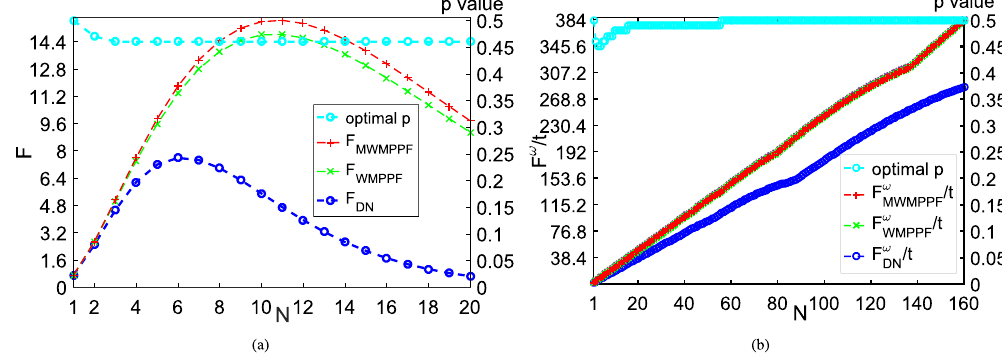
Figure 7. ( a ) Average QFI of phase φ vs. N and optimal p of F MWMPPF vs. N with N = 1 to 20 while r = 0.3, θ = π /2. (1) F DN (blue dashed line) for DN case; (2) F WMPPF (green dashed line), provided that p is fixed with 0.5; (3) F WMWPPF (red dashed line) is the maximum of F WMPPF by choosing the optimal p value when r = 0.3; (4) the optimal p value for average QFI (celeste dashed line) according to N can be drawn at the same parameters with the coordinate scale on the right edge of the figure, which is the p of F MWMPPF . ( b ) Average QFI of frequency ω divided by t (or average QFI of phase multiplying t ) vs. N and optimal p of ω F t / vs. N with N = 1 to 160 MWMPPF and Γ = 0.3 while t and p are both optimized. (1) ω F t / (blue dashed line) for DN case; (2) ω F t / (green DN WMPPF dashed line), provided that p is fixed with 0.5; (3) ω F t / (red dashed line) is the maximum of ω F t / by MWMPPF WMPPF choosing the optimal p value when r = 0.3, which is very close to ω F t / especially when N ≥ 56; (4) the WMPPF optimal p value for average QFI (celeste dashed line) according to N can be drawn at the same parameters with the coordinate scale on the right edge of the figure.